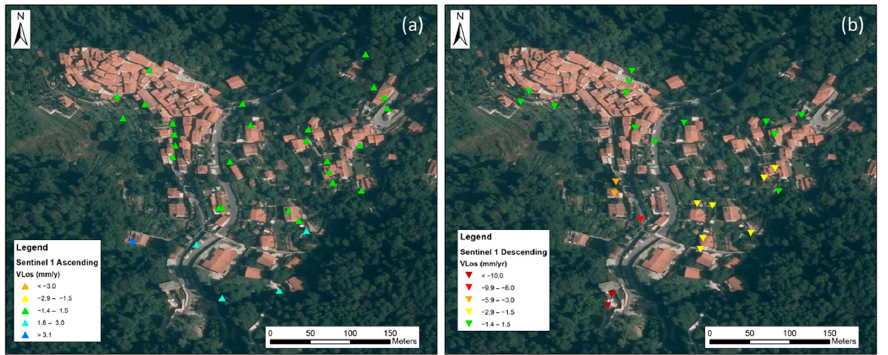
Figure 10. Ground LOS deformation velocity maps of the village of Pariana: ( a ) Sentinel 1 ascending; ( b ) Sentinel 1 descending.